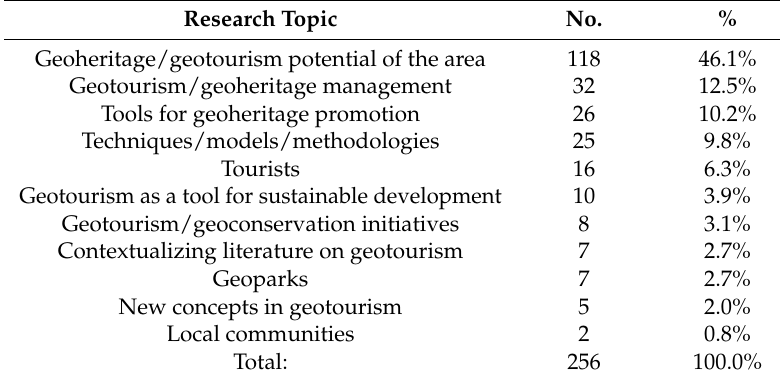
Table 2. Research topics covered in the reviewed papers.